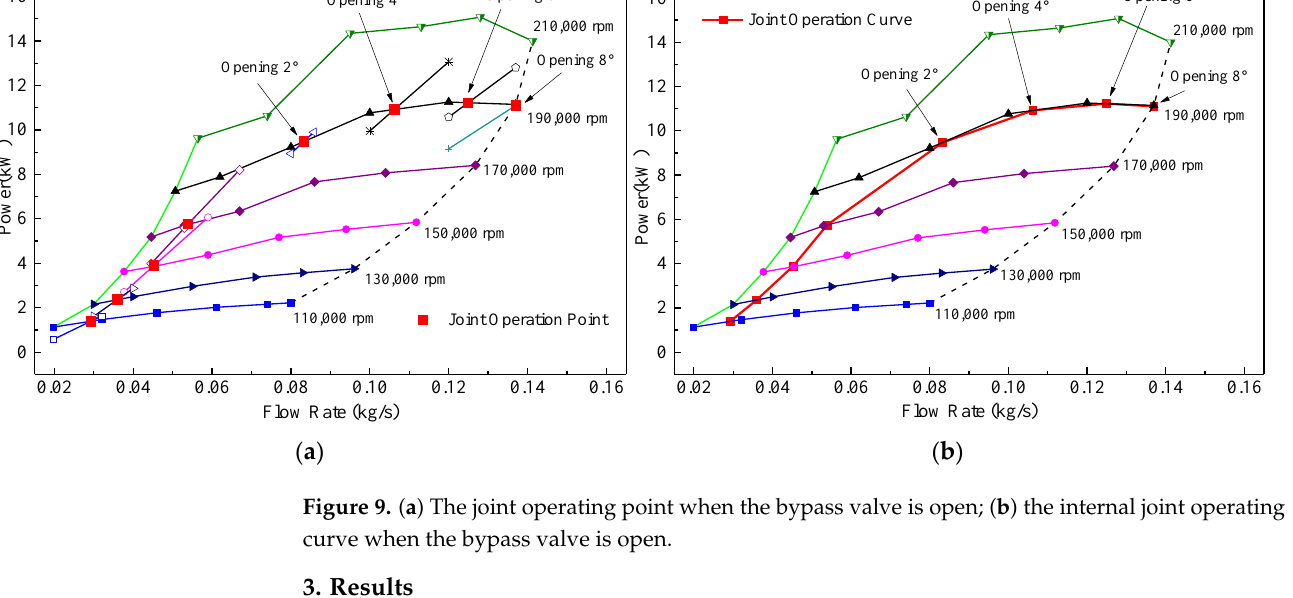
Figure 8. Definition of the power balance at 150,000 rpm.